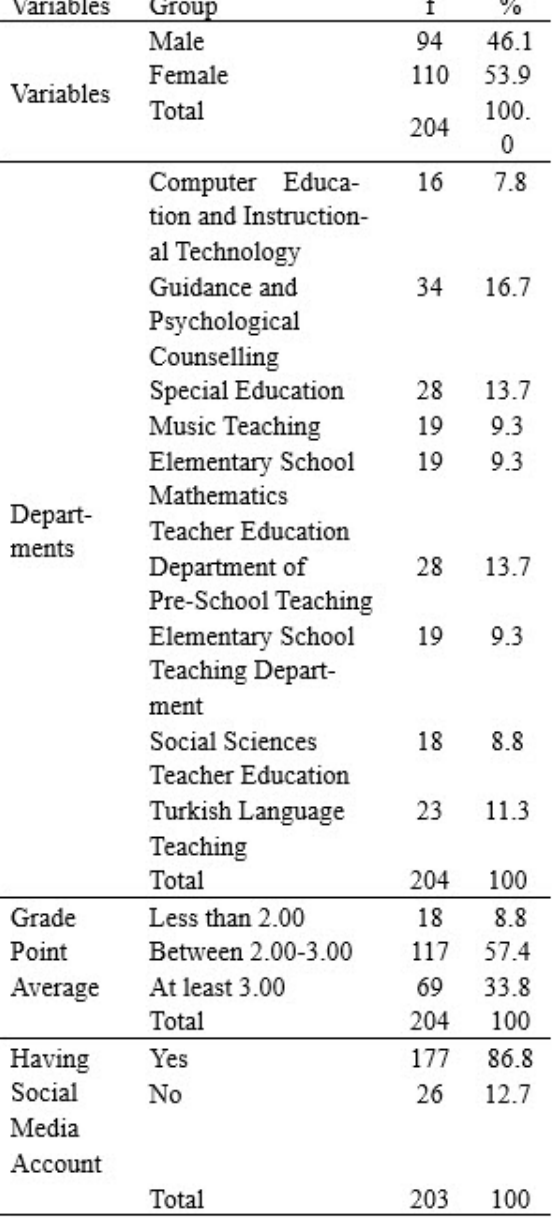
Table 1. Demographic profile of the par -